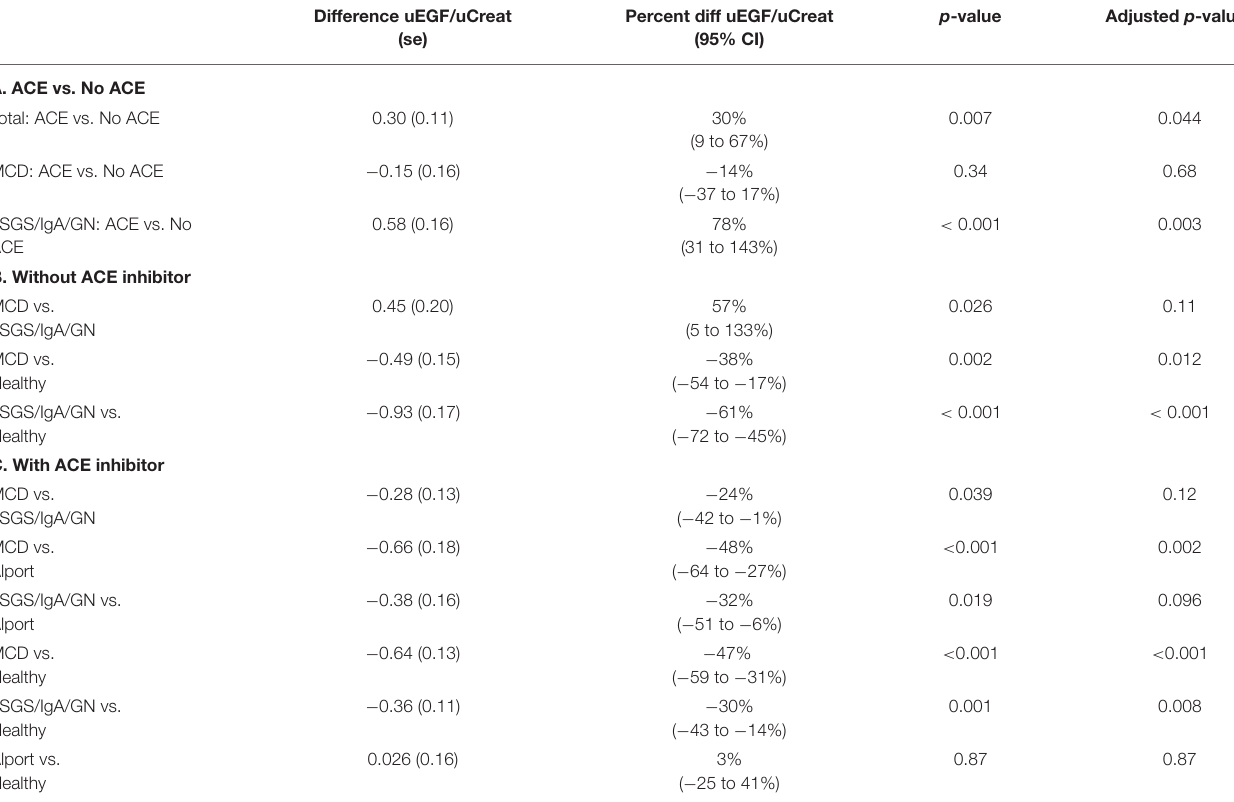
TABLE 6 | The effect of ACE inhibition on uEGF/uCreat according to the biopsy diagnosis.